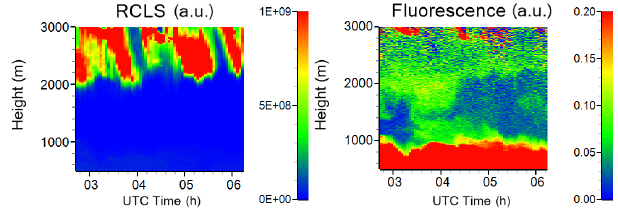
Figure 7. Height–time distribution of the range-corrected lidar sig- nal (RCLS) at 1064nm and the fluorescence backscattering coeffi- cient on 15 November 2019.